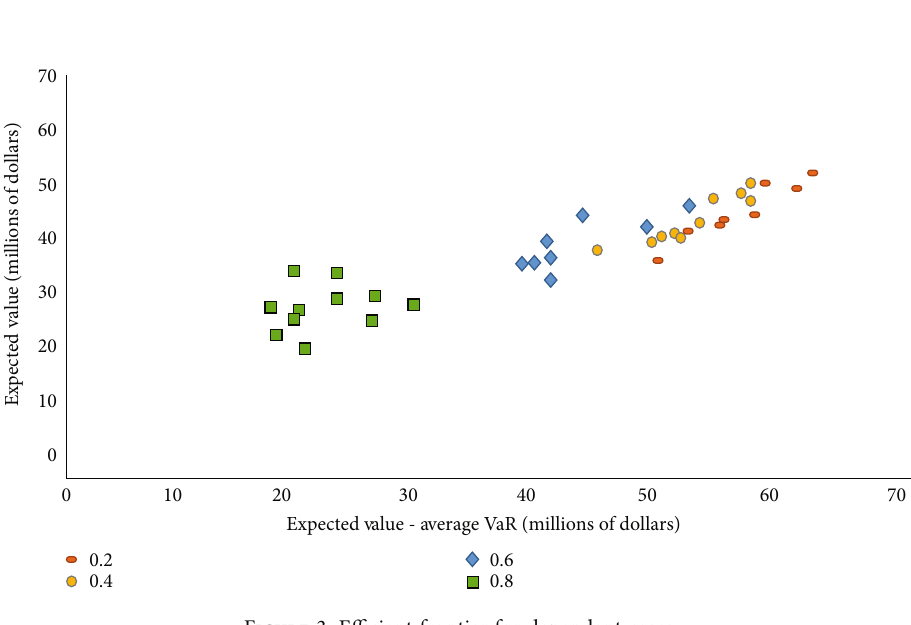
Figure 3: E ffi cient frontier for dependent